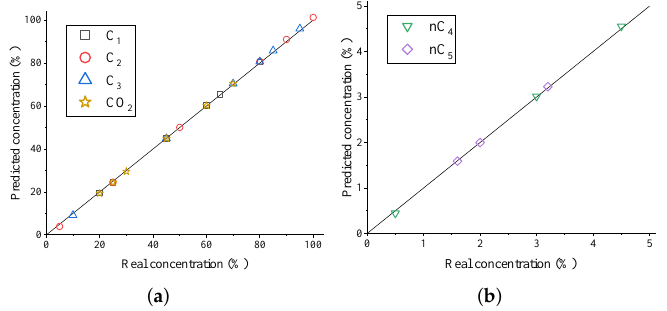
Figure 11. The correlation between the actual concentration and the predicted concentration of samples in the one-component test set. The horizontal axis is the real concentration, and the vertical axis is the predicted concentration of ASS-PLS model, the black line means predicted concentration equal to real concentration. ( a ) Prediction of C 1 , C 2 , C 3 and CO 2 . ( b ) Prediction of nC 4 and nC 5 .